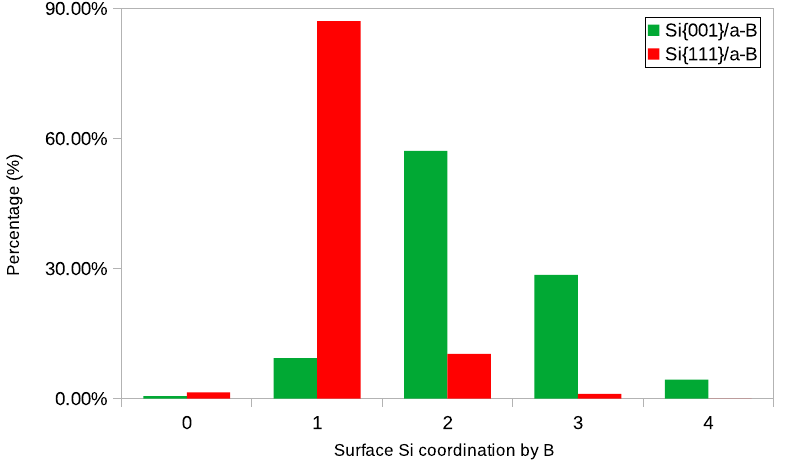
Figure 8. Distribution of the numbers of the coordination number of the interfacial Si atoms by boron at The Si{0 0 1}/a-B (circles) and Si{1 1 1}/a-B (squares)